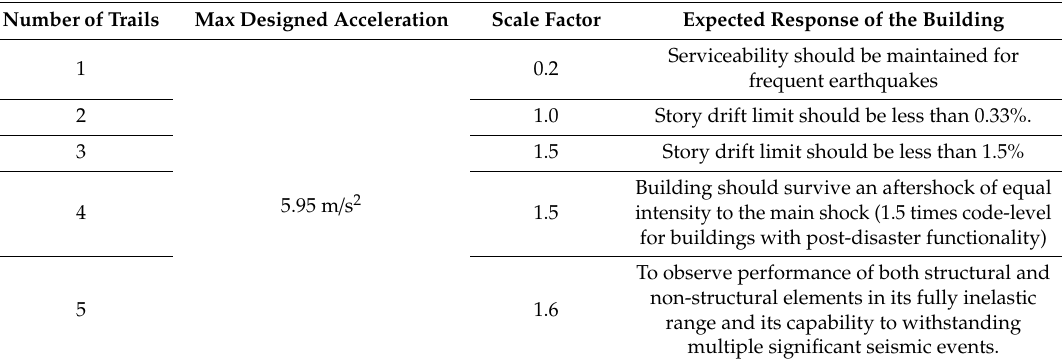
Table 6. Expected response of the